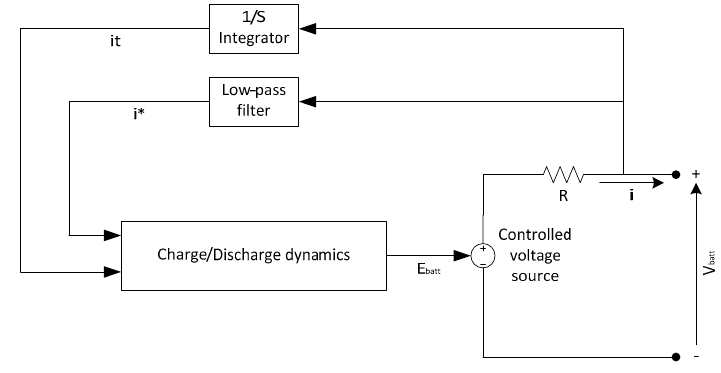
Figure 2. Tremblay and Dessaint battery discharge model.